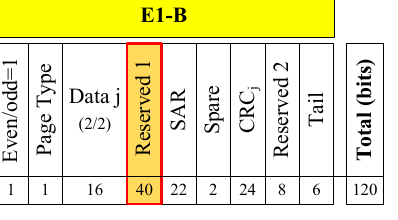
Figure 2. GALILEO NMA message structure [25].